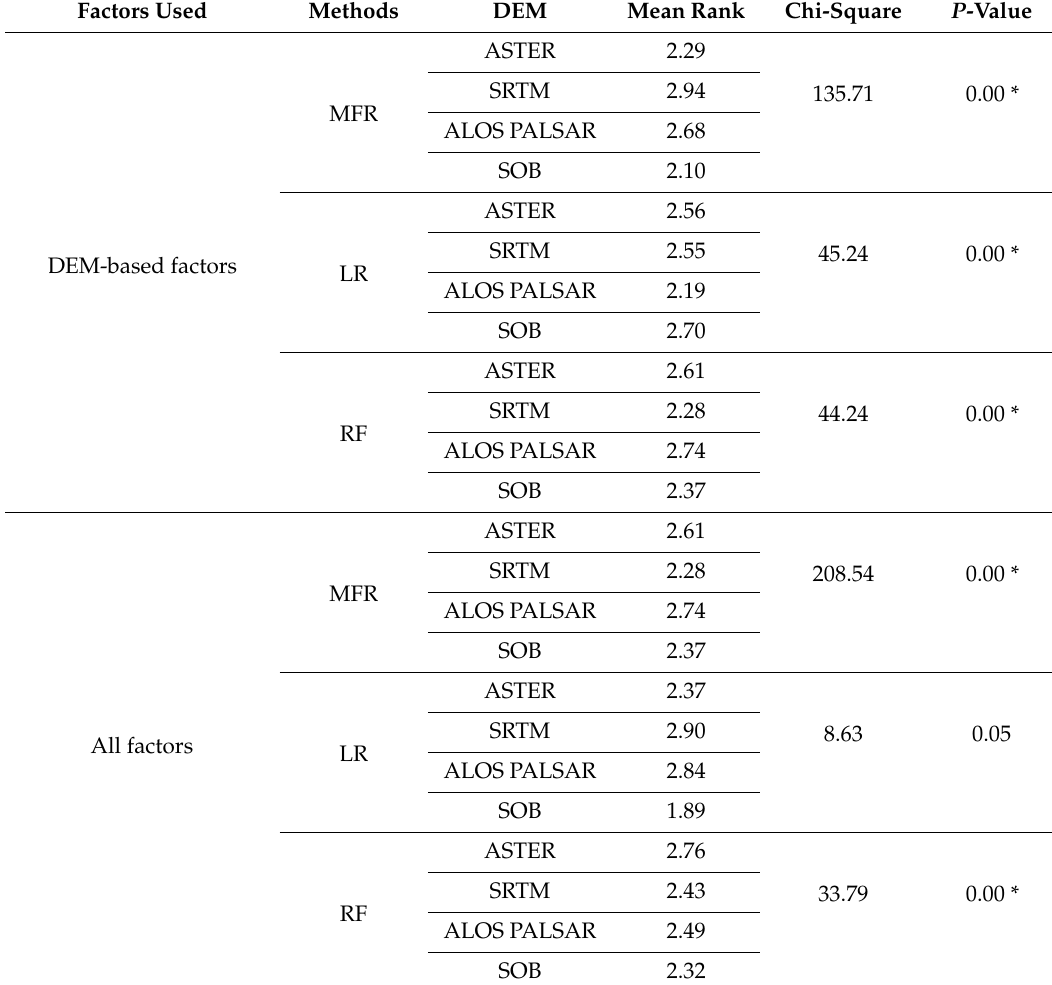
Table 4. Result of the Friedman Test for landslide susceptibility